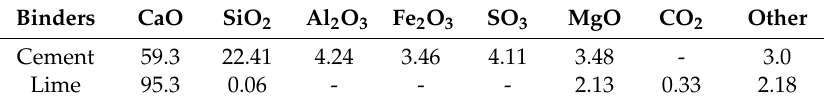
Table 2. Composition of Portland cement and lime used in this study (%).